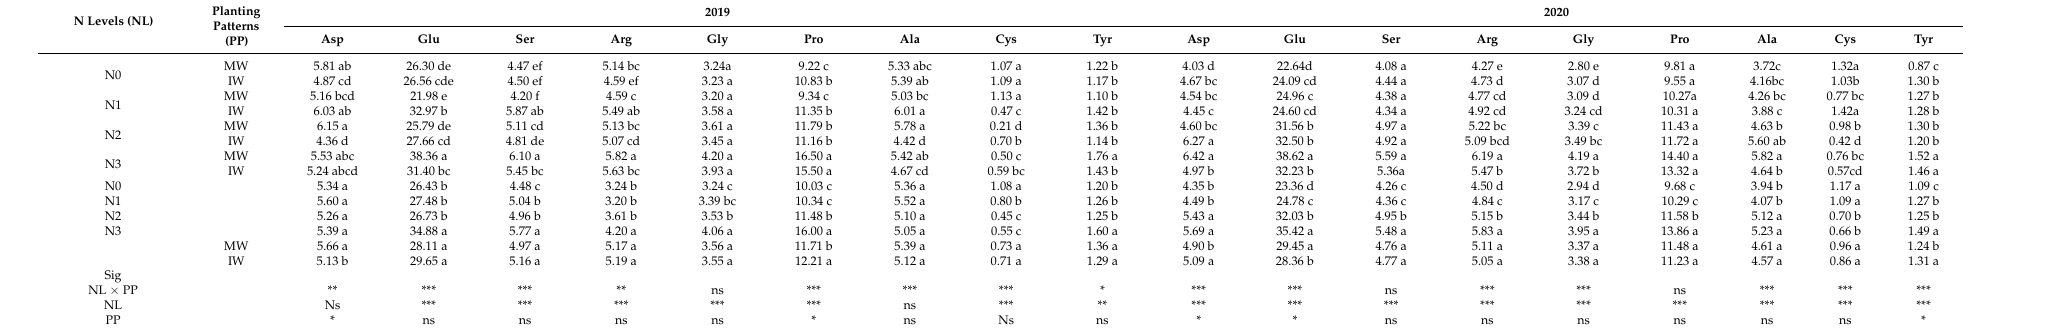
Table 5. The fraction content of each non-essential amino acids in grain for inter- and mono-cropped wheat grain under different N levels. NLevels(NL) Planting Patterns